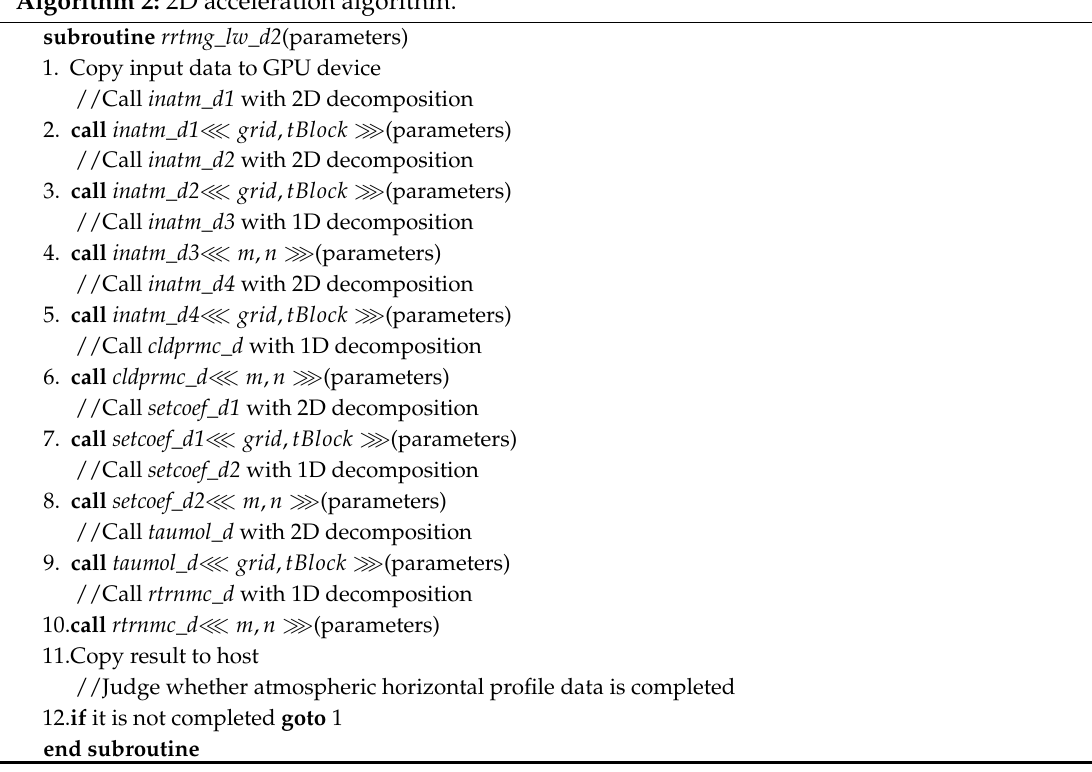
Algorithm 2: 2D acceleration